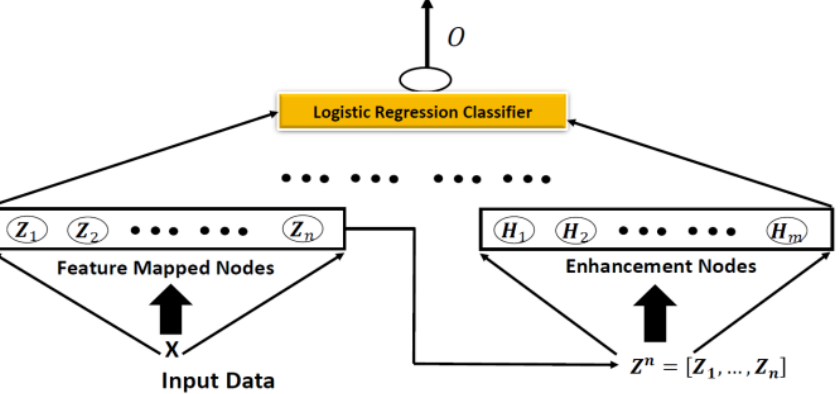
Figure 5. The Flowchart of the proposed network and procedure. In Figure 5, input X is passed to the feature-mapped layer, where the feature Z n is extracted and obtained. This feature is further enhanced to obtain an enhanced feature H m . Both features are combined as A = [ Z n | H m ] . The concatenated features are then passed to the logistic regression classifier for making the decision. The fusion of logistic regression and broad learning system, with the effectiveness of the feature-extraction layer and enhancement layer improves the performance of the network. For instance, when the feature nodes extract features from the input X, the enhancement nodes further enhance the features such that the distance between the positive class and negative class is